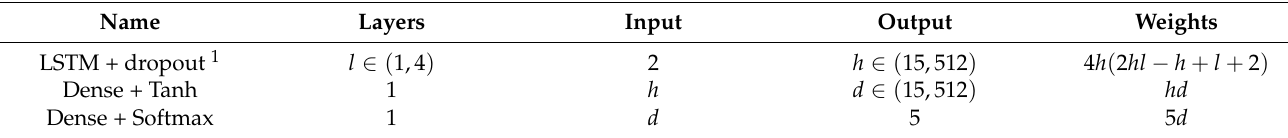
Figure 1. Diagram showing the general architecture of the considered models. Table 2. General architecture of the considered